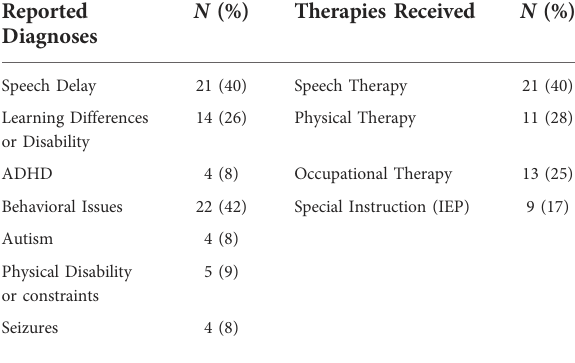
TABLE 3 Neurodevelopment: parent interview responses ( n =53).